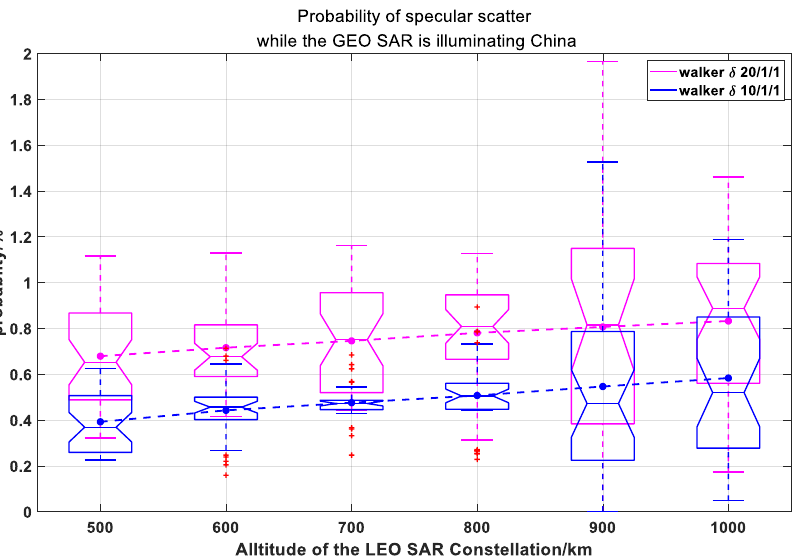
Figure 11. Probability of specular scatter while the GEO SAR is illuminating China. The magenta box line shows the case of a LEO SAR constellation which uses a 20/1/1 walker pattern. The magenta points are the average of the probability for every altitude in 20/1/1 walker pattern. The blue box line shows the case of a LEO SAR constellation which uses a 10/1/1 walker patten. The blue points are the average of the probability for every altitude in 10/1/1 walker pattern.